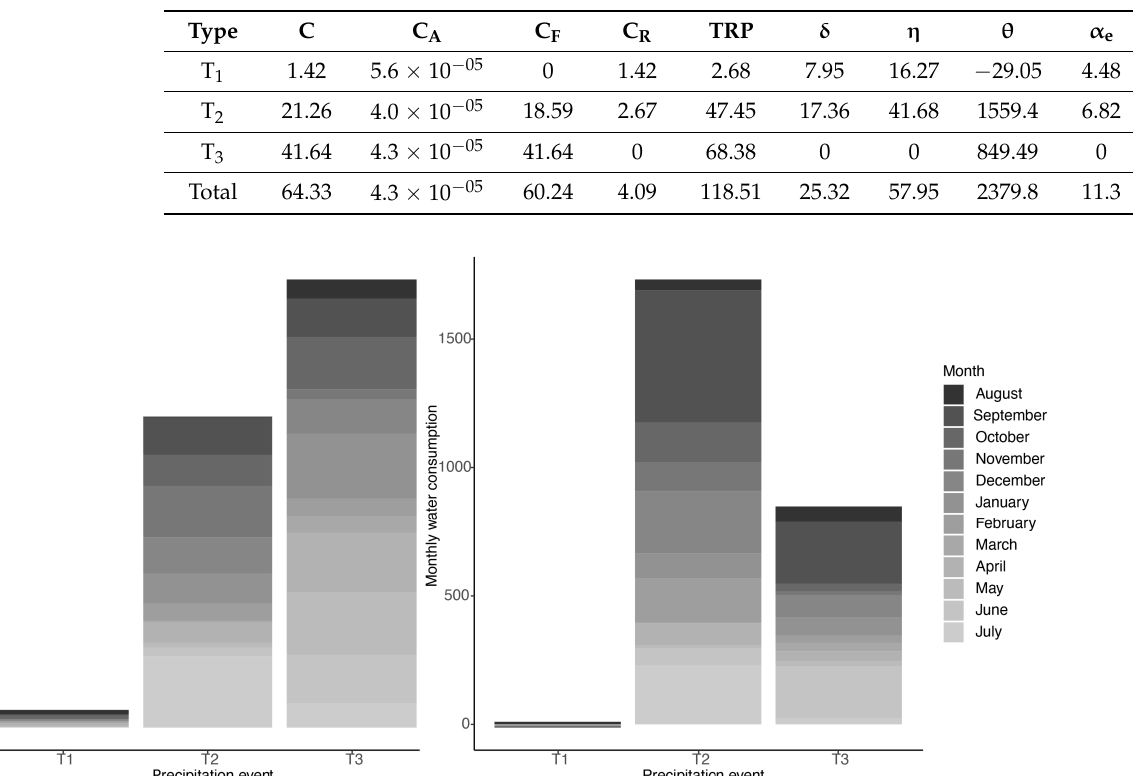
Table 2. Values of total (C), average (C A ), fog (C F ), and rainfall (C R ) condensation; transpiration (TRP); and water stored ( δ ), absorbed ( η ), used ( θ ), and for extra storage ( α e ). Data are given in mm according to the type of precipitation event (T 1 , T 2 , and T 3 ; see details in Materials and Methods).